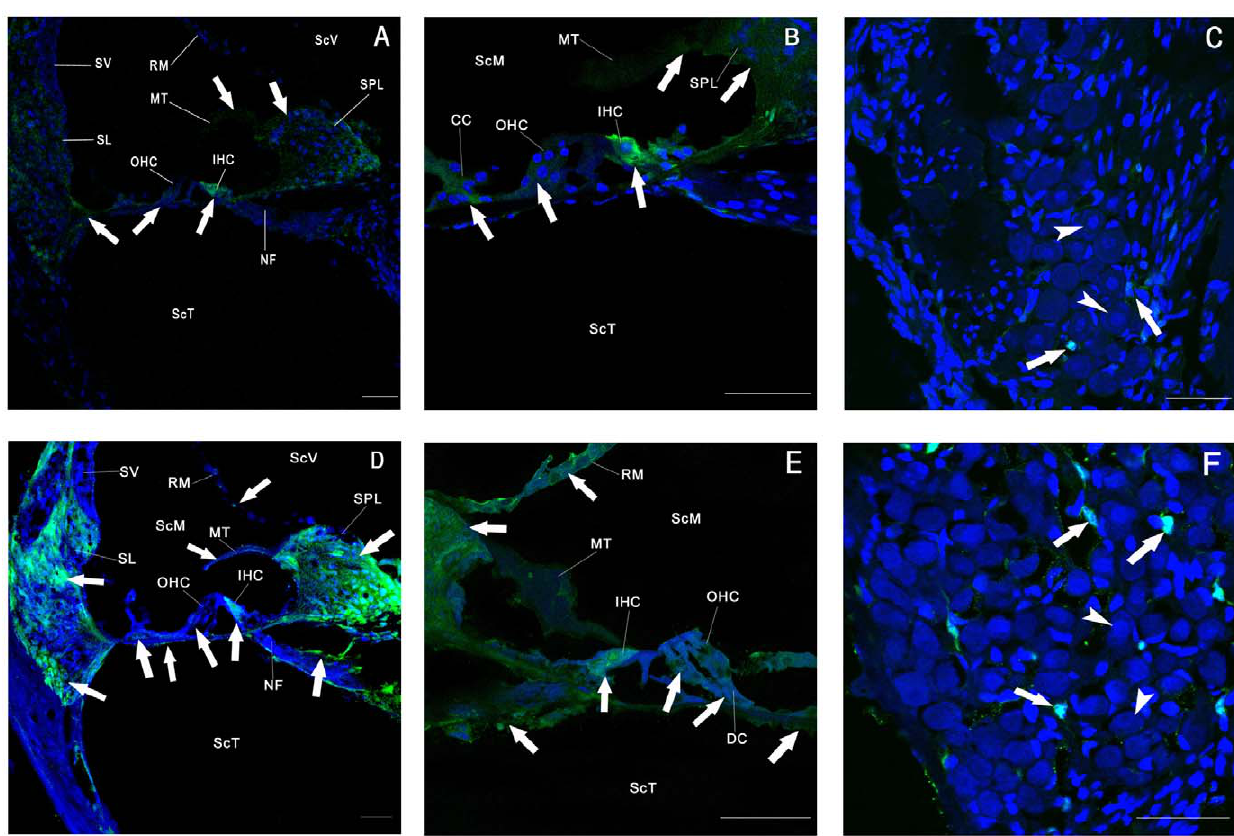
Figure 5. Cross-sectional view of the basal turn of cochlea showing cochlear transfection. In the trans-RWM subgroup of RWM treatment with 60 mg/mL collagenase. A–C: Strong GFP signals were observed in the IHCs, Claudius cells, membrana tectoria, spiral limbus, and spiral ligament; GFP staining was weak in the OHC (A and B). Few GFP-positive type II SGNs were found (arrows in C), and no staining was observed in type I SGNs. RWM-puncture group D–F: the relative transfection across different cell types and locations was similar to the trans-RWM group, but the GFP signal was generally stronger in the RWM-puncture group. GFP-positive type II SGNs (arrows in F). Arrowhead: type I SGNs. ScV: scala vestibule; ScT: scala tympani; ScM: scala media; OHC: outer hair cell; IHC: inner hair cell; SGNs: spiral ganglion neurons; CC: Claudius cell; DC: Deiters cell; SL: spiral ligament; SV: stria vascularis; MT: membrana tectoria; RM: Reissner’s membrane; SPL: spiral limbus; NF: nerve fibers. Scale bars=50 m m.